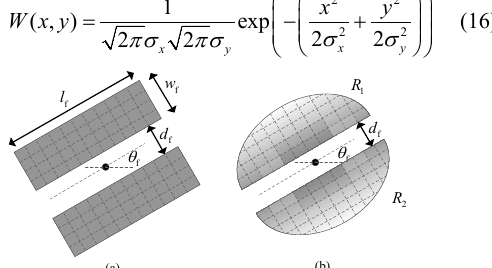
Fig. 1. Filter configuration. (a) Rectangle-shaped filter.